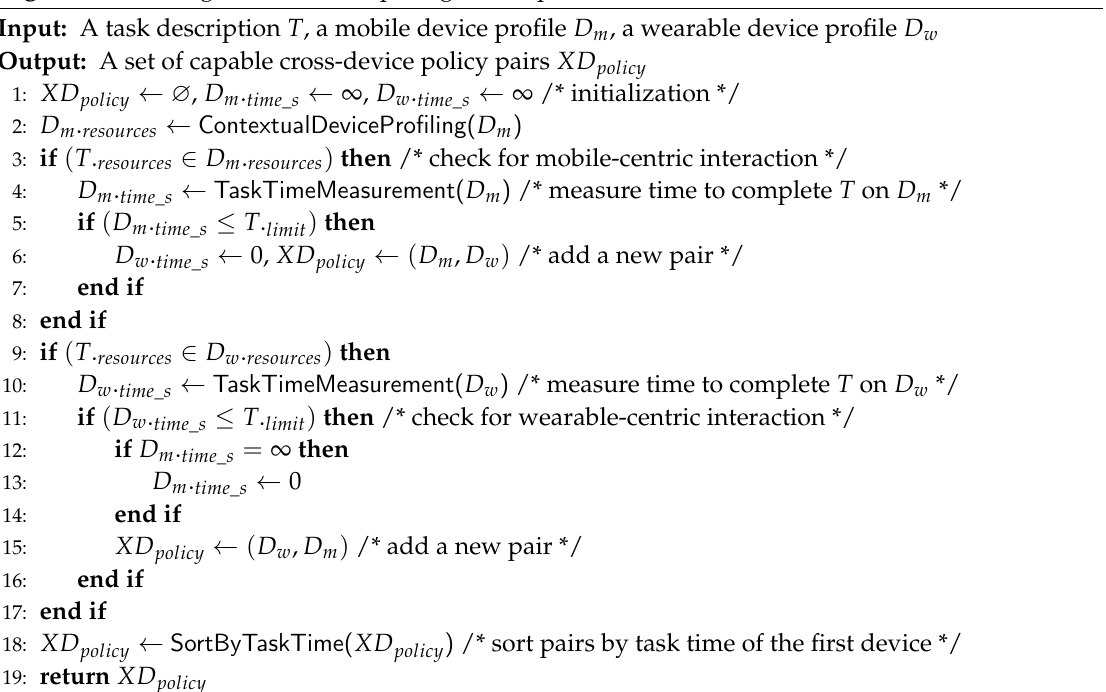
Algorithm 1 An algorithm for computing XDCC